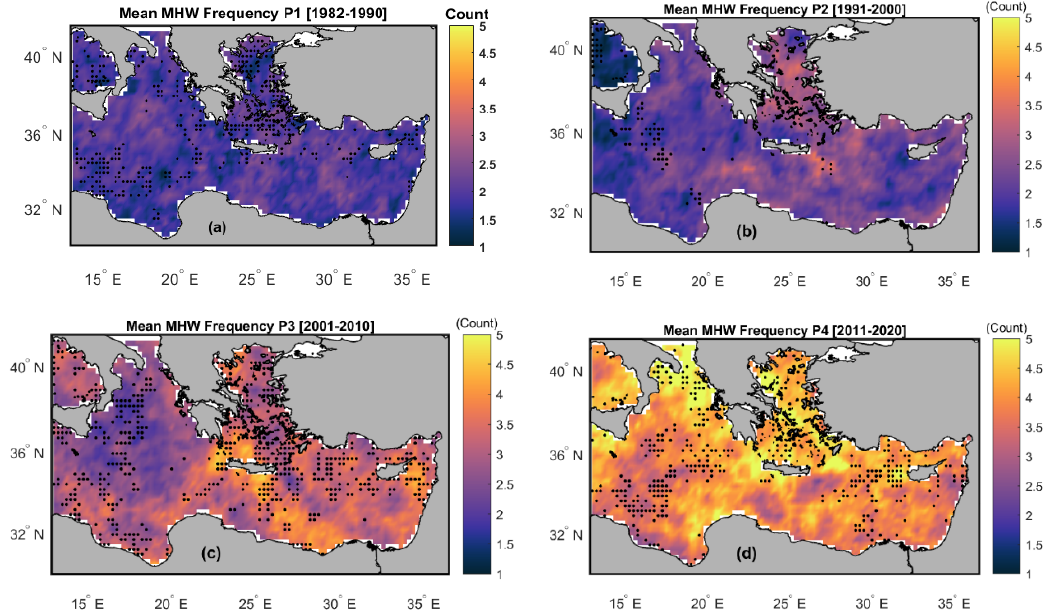
Figure 7. The EMED MHWs mean frequency (Count) for ( a ) P 1 (1982–1990), ( b ) P 2 (1991–2000), ( c ) P 3 (2001–2010) and ( d ) P 4 (2011–2020), and the black dots indicate the change is not significantly different ( p > 0.05).